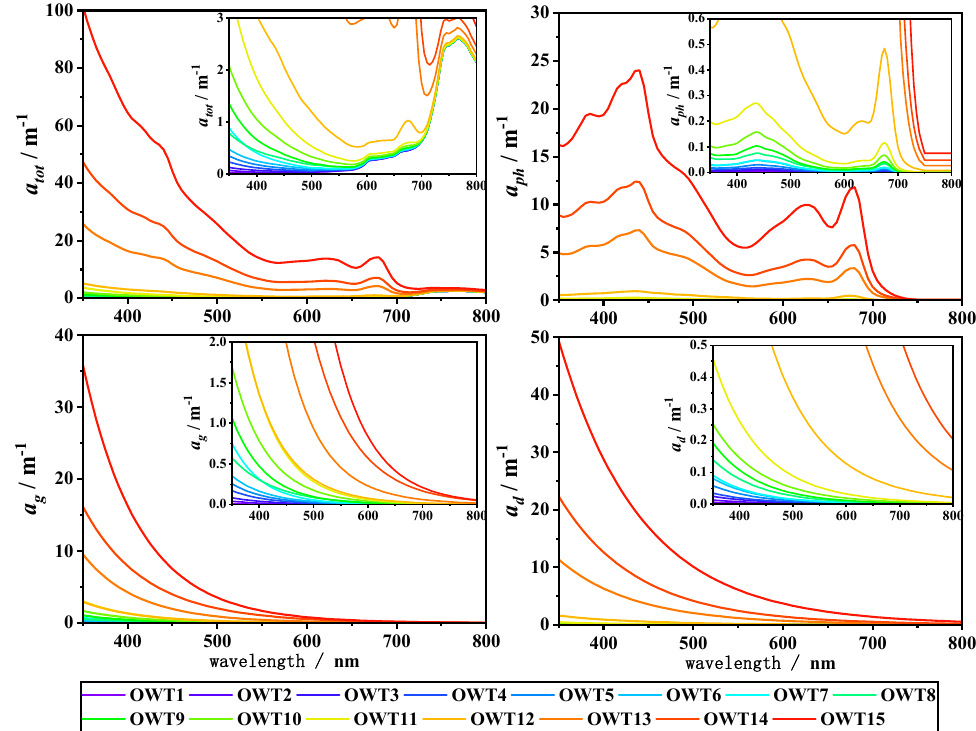
Figure 11. Average total absorption coefficients a tot ( λ ), average phytoplankton absorption coefficients a ph ( λ ), average gelbstoff coefficients a g ( λ ), and average non-algal particles absorption coefficients a d ( λ ) of each U-OWT class. Similar to a ternary plot of the individual absorption contributions, a line chart de- picting the contributions of a ph (440), a g (440), and a d (440) to total absorption after subtract- ing water contribution is in Figure 12. From OWT1 to OWT11, η ( a ph ) and η ( a d ) decreased gradually, while η ( a g ) increased gradually and exceeded η ( a ph ) and η ( a d ). The transition was at OWT12; in this water class, η ( a ph ) and η ( a d ) increased while η ( a g ) decreased. At OWT13-15, the comparison between the individual contributions was η ( a ph ) > η ( a d ) > η ( a g ).